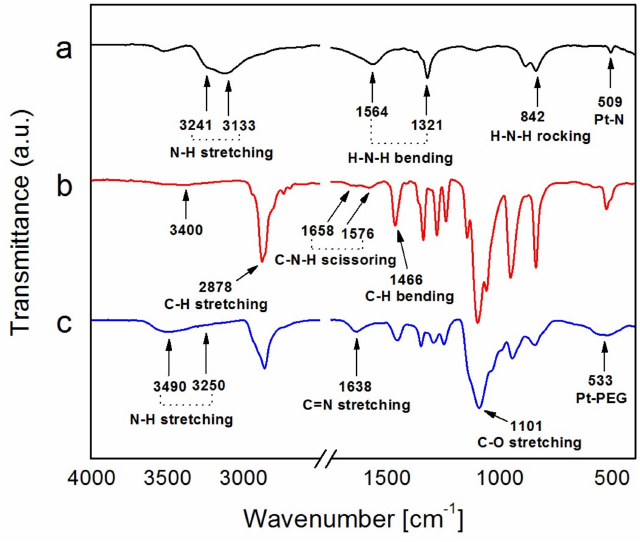
Figure 4. Fourier Transform InfraRed (FTIR) spectra of ( a ) Pt(NH 3 ) 4 Cl 2 , ( b ) PEG-diamine 2000 and ( c ) Pt